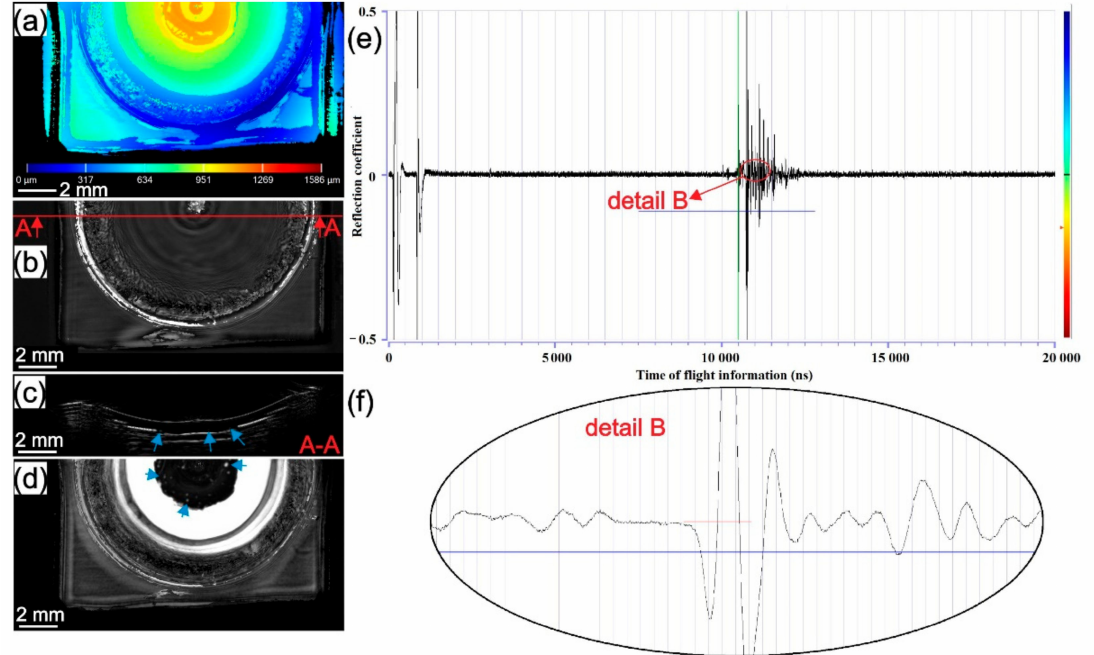
Figure 9. The sample from batch II welded with 4500 rpm: ( a ) topography map from the top of the sample; ( b ) C-scan with gate position 20 ns and gate length 50 ns with A-A cross-section showing the place where B-scan was obtained; ( c ) B-scan from A-A cross-section; ( d ) C-scan with gate position 220 ns and gate length 50 ns as shown in detail B with red line on A-scan; ( e ) A-scan with detail showing the gate length of C-scan from ( c ); ( f ) detail of A-A scan from ( e